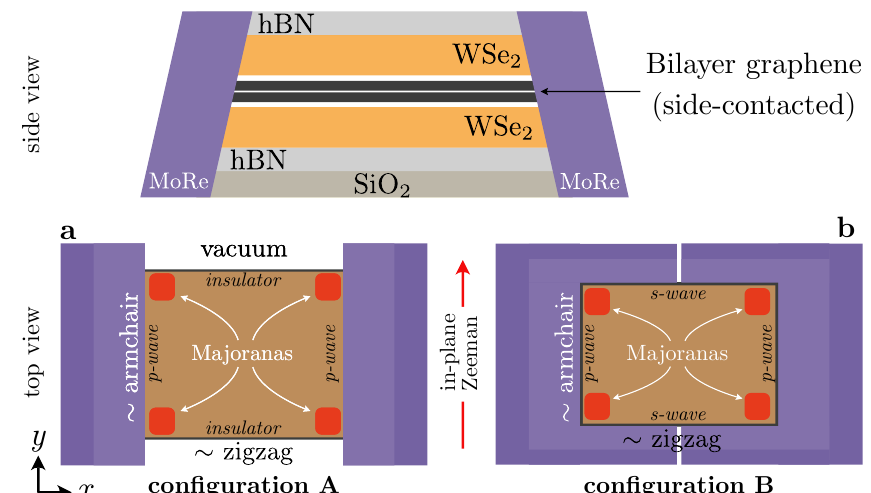
Figure 1: Lateral and top views of proposed device configurations A and B for the generation of Majorana bound states (MBSs) (schematically represented in red). The device is composed of a graphene bilayer (black), encapsulated in a transition metal dichalcogenide (TMDC) (orange) and laterally contacted with conventional s-wave superconductors (purple). The superconductor split in (b) creates a weak link that allows to phase-bias the